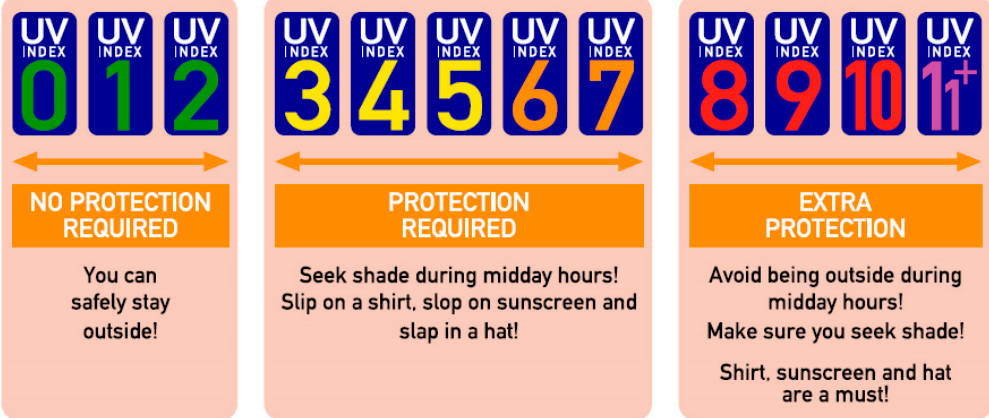
Figure 1. UV Index (UVI) guidance according to the WHO. Figure modified from [16]. The modification consists of the explicit graphical representation of the value zero in the ‘low exposure’ category, which is not part of the original WHO figure but is mentioned to belong to this category in the text